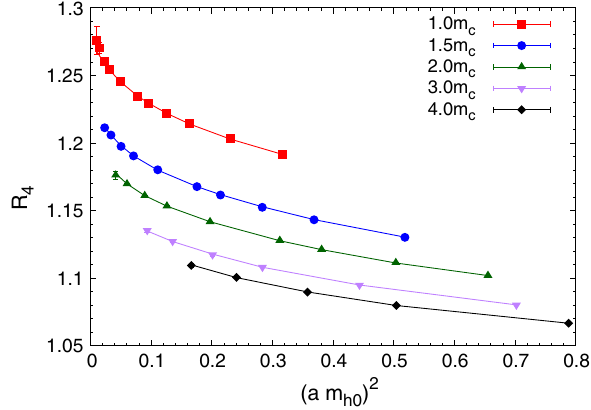
Fig. 1 The lattice spacing dependence of R 4 ( m h ) for different values of the heavy-quark mass. The lines represent the fit with Eq. (8) with N = 2, M 1 = 8, M 2 = 6 and ( am h ) 2 max = 0 . 7, see